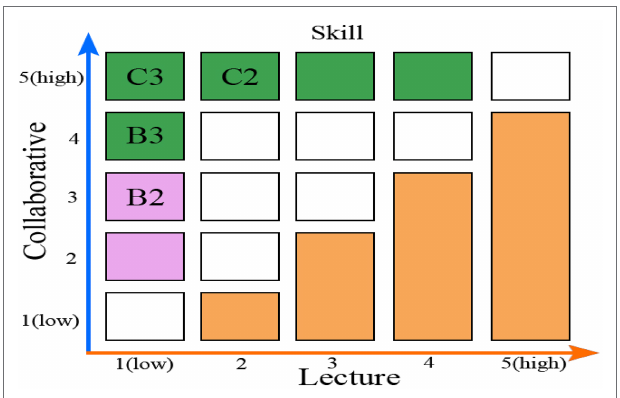
FIGURE 3 | Comparison of collaborative teaching versus